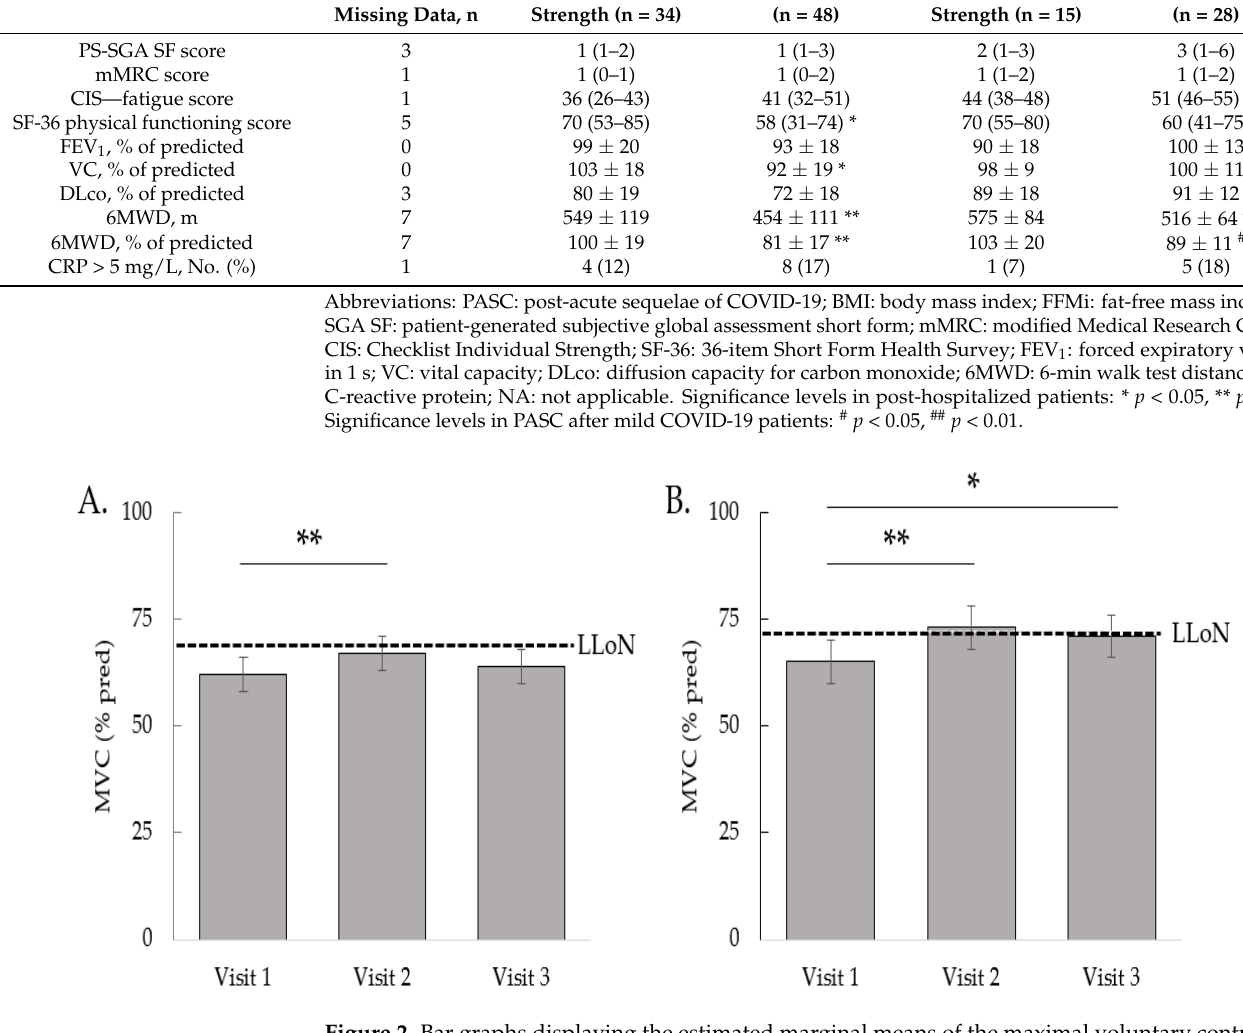
Figure 2. Bar graphs displaying the estimated marginal means of the maximal voluntary contraction (MVC) expressed as percentage of the predicted value at the three visits in post-hospitalized patients ( A ) and in patients with PASC after mild COVID-19 ( B ). Error bars represent 95% CI and dashed lines represent cohort-specific mean lower limit of normal (LLoN). * p < 0.05, ** p < 0.01.